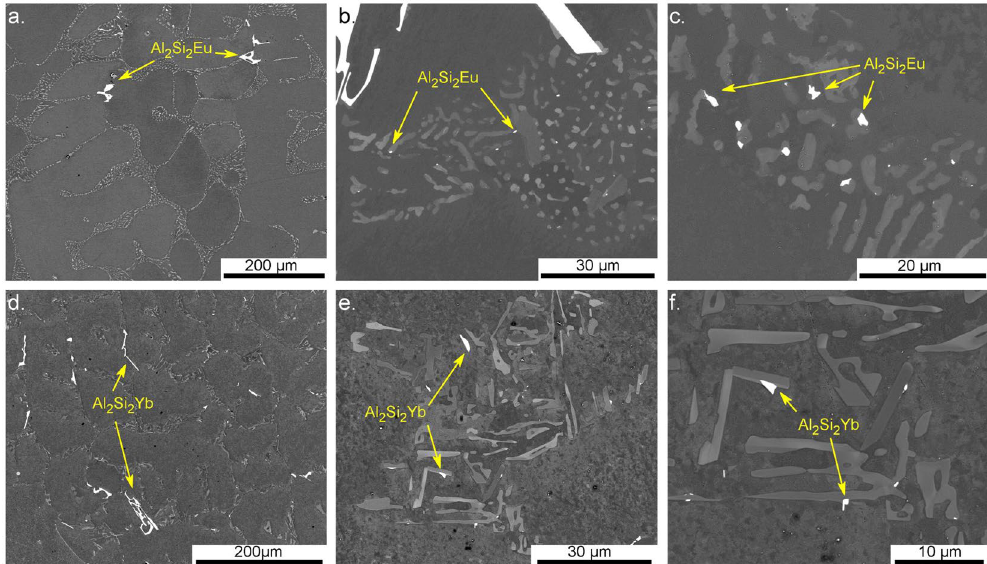
Figure 1. SEM micrographs of Al-5 wt.%Si with either Eu ( a – c ) or Yb ( d – f ) additions. ( a ) Coral-like eutectic phase and pre-eutectic coarse Al 2 Si 2 Eu intermetallics; ( b , c ) smaller Al 2 Si 2 Eu intermetallic phases formed during eutectic growth. ( d ) Refined structure resembling the plate-like eutectic phase of unmodified alloys and coarse Al 2 Si 2 Yb intermetallics; ( e , f ) smaller intermetallic phases forming during eutectic